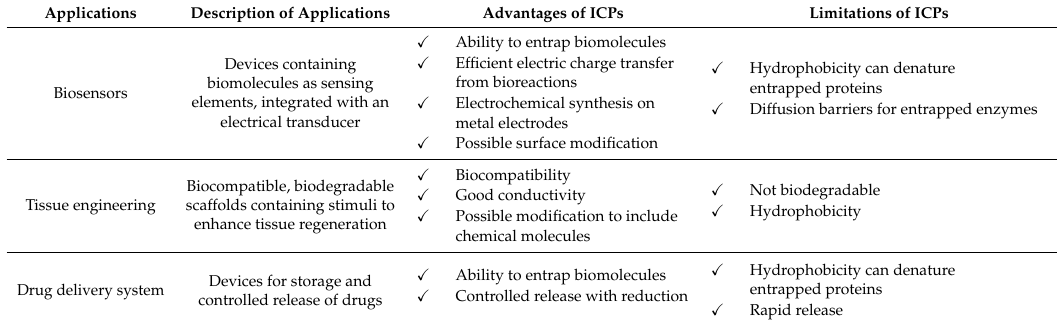
Table 2. ICPs in biological applications [208].